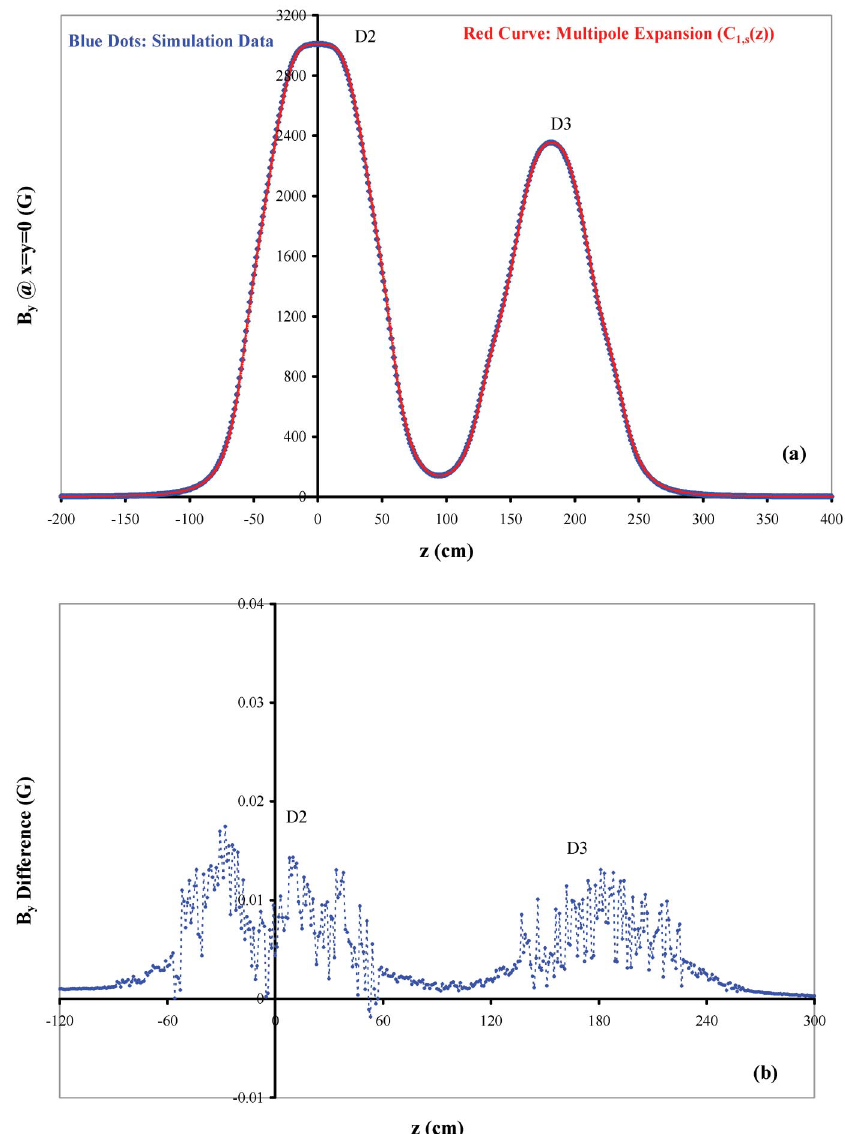
FIG. 11. (Color) (a) B at x (cid:2) y (cid:2) 0 versus z ; (b) Difference in B y